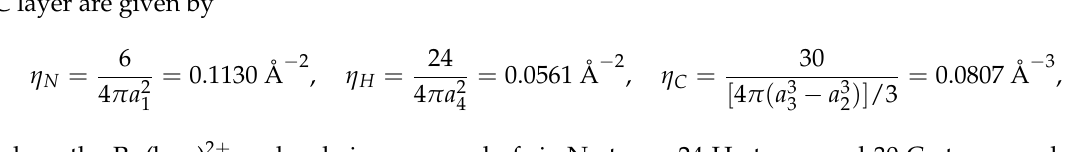
molecule: ( a ) Model I: Spherical layers and ( b ) Model II: 3